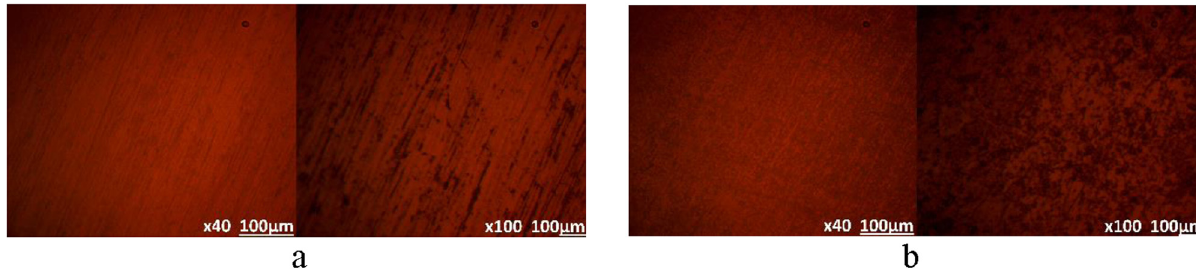
Figure 6: Optical images of B265TiQ after corrosion test in ( a ) 2 M H 2 SO 4 + 10% NaCl and ( b ) 10 M H 2 SO 4 + 10% NaCl at 30°C.